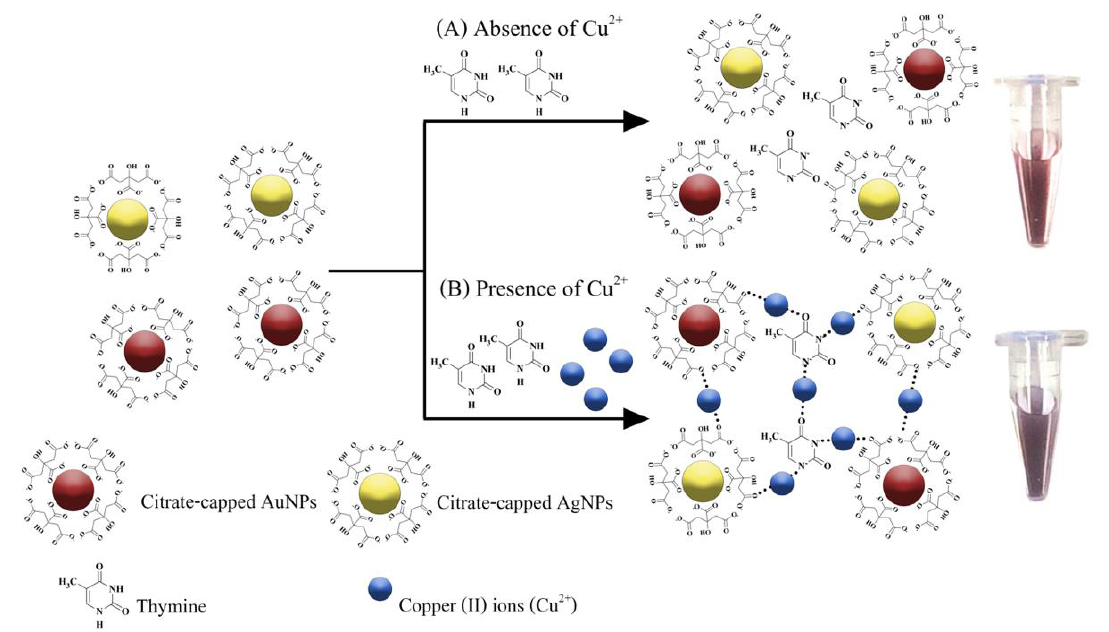
Figure 1. Schematic representation of the principle of colorimetric detection of Cu 2+ based on a Thy- AuNP-AgNP hybrid system in the ( A ) absence or ( B ) presence of Cu 2+